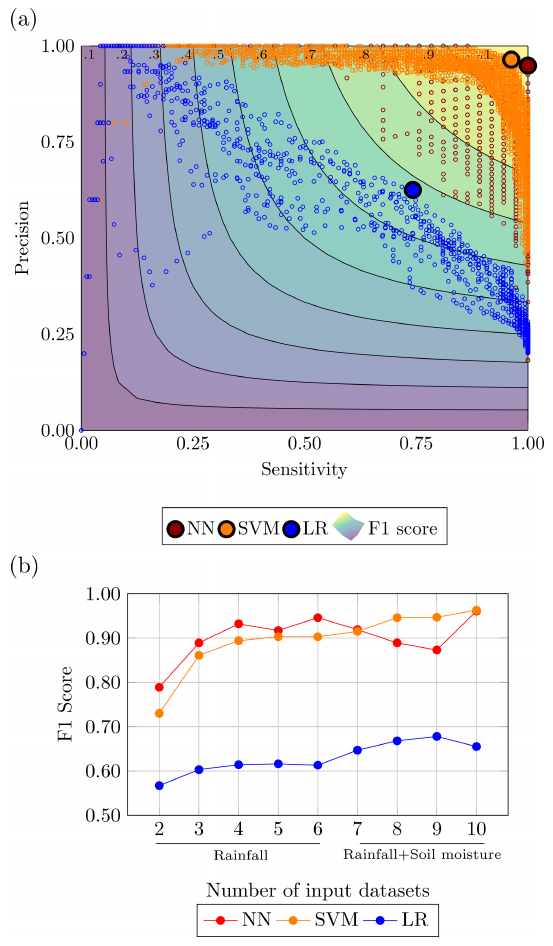
Figure 13. Performance evaluation for the drought case: (a) per- formances of the top 1% configurations in the precision-sensitivity space highlighting the highest F1 score and (b) comparison of ML methods with LR with combination using increasing number of in- put